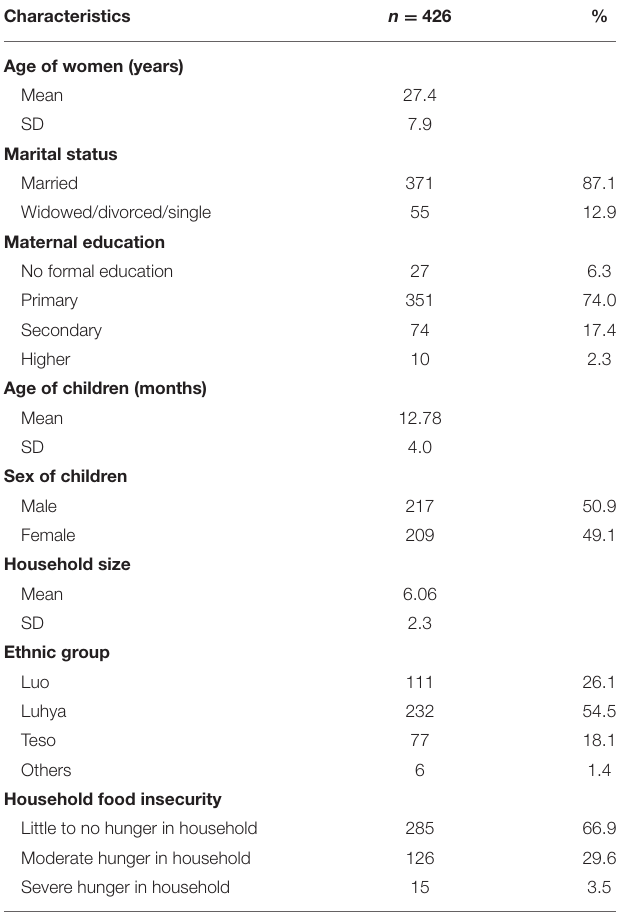
TABLE 2 | Basic characteristics of study population in Western Kenya ( n =